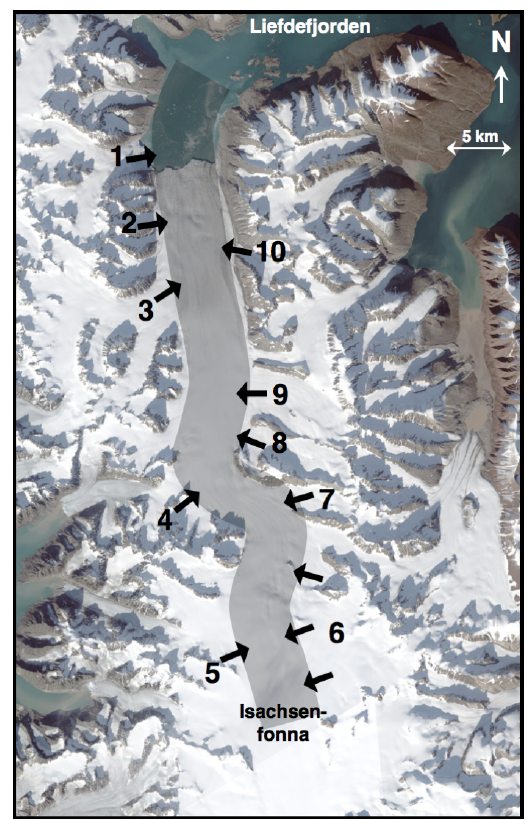
Figure 2. The 43km long and 5km wide flowband (grey) used to model Monacobreen, shown as an overlay on a Landsat image (© Norsk Polarinstitutt). The tributary glaciers and basins are num- bered 1 to 10, and the corresponding geometric properties are listed in Table